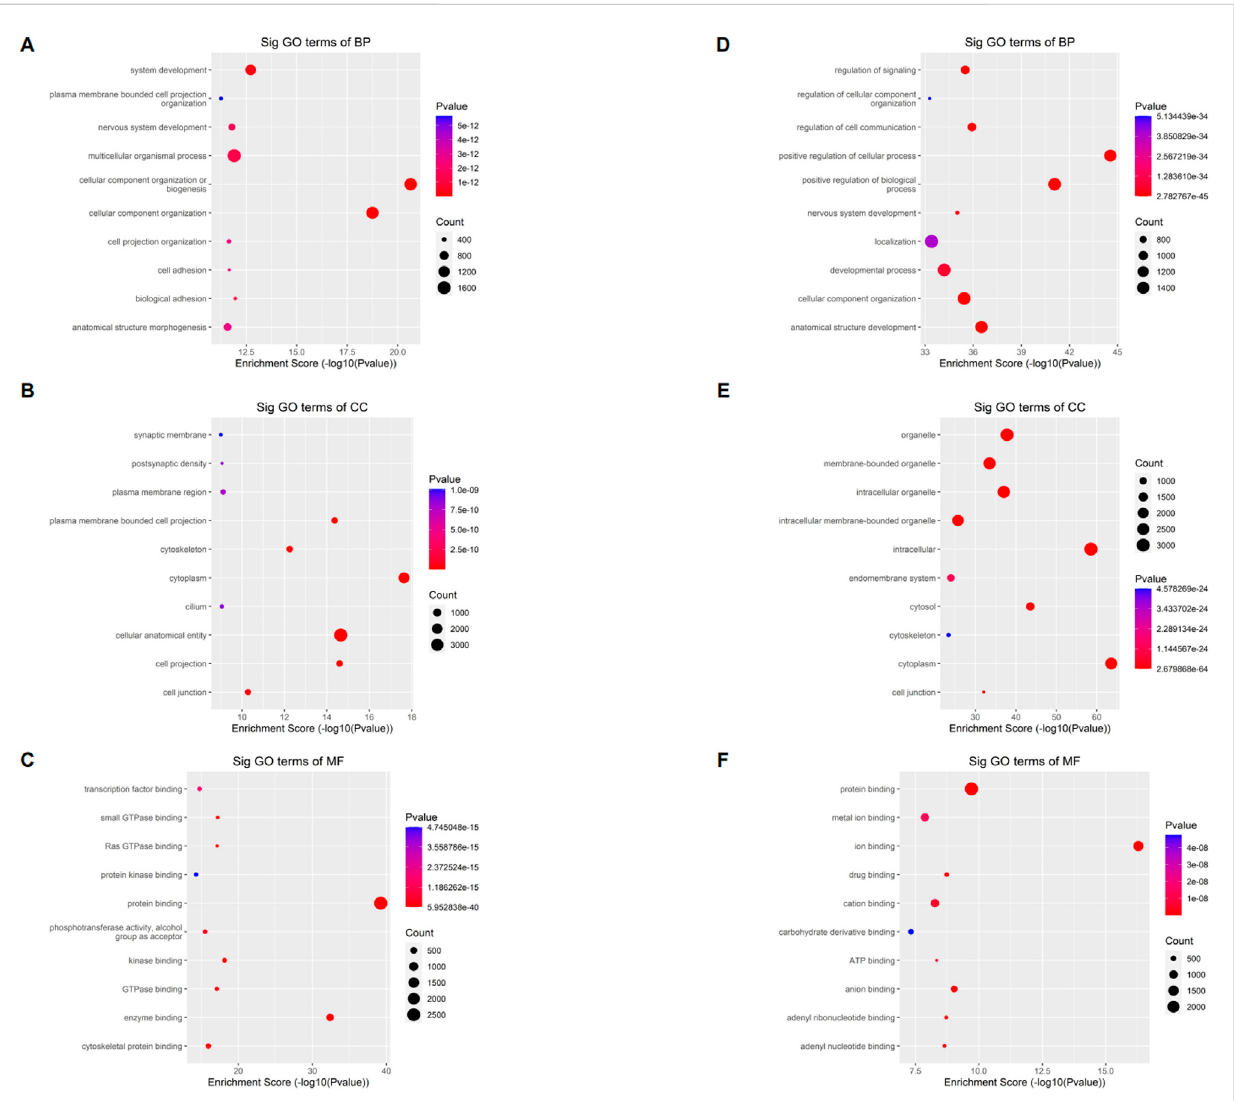
FIGURE 4 GeneontologyanalysesofHCT15andshNSUN2-HCT15cell (A) Biologicalprocesses, (B) cellularcomponents,and (C)